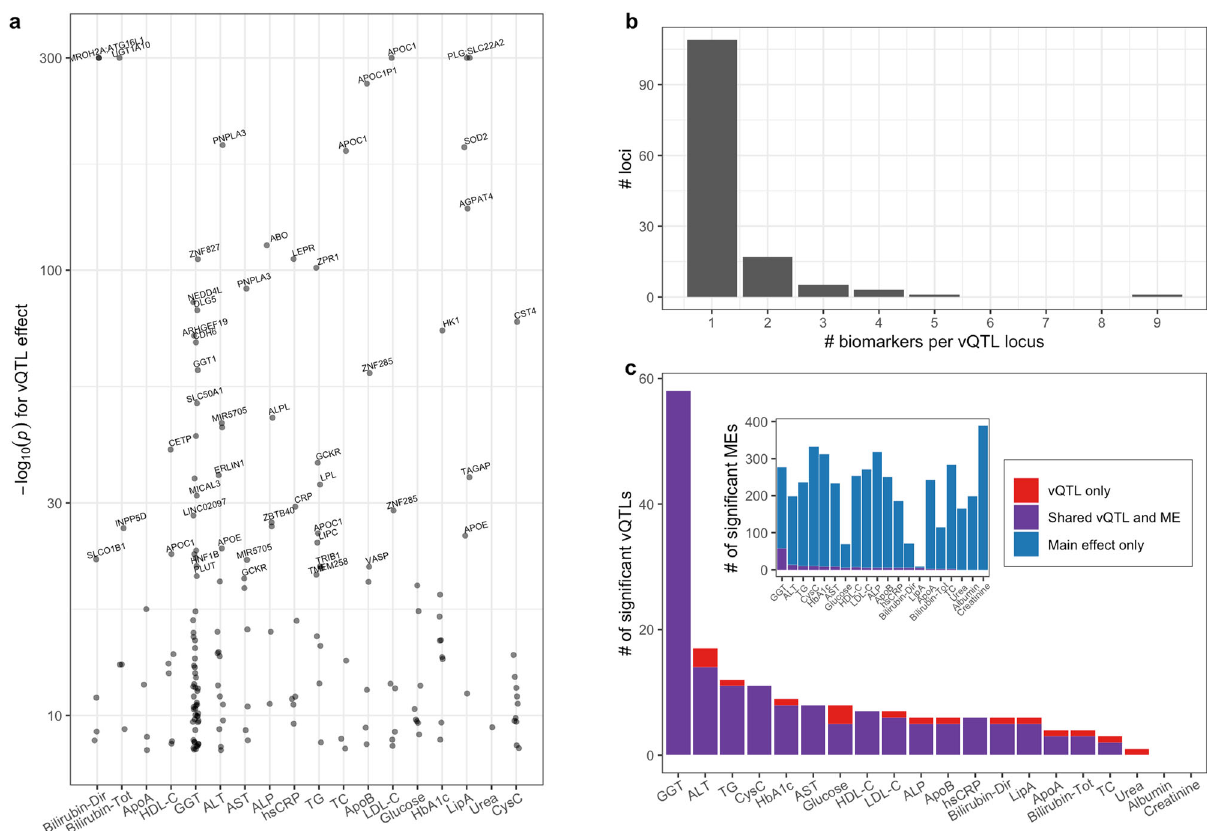
Fig. 2 vQTLs identi fi ed across 20 cardiometabolic serum biomarkers. a − log 10 P vQTL from Levene ’ s test is shown for all signi fi cant index variants for each biomarker. Labels correspond to the closest gene (shown for variants with P vQTL < 10 − 20 ), highlighting some known GWAS loci. P values are truncated at 10 − 300 for visualization purposes. b Histogram displaying the number of biomarker associations for each vQTL locus. c The number of signi fi cant vQTL loci is shown for each biomarker (inset: analogous plot for main effects). Colors denote three categories: vQTL loci not shared with an ME locus (red), vQTL loci shared with an ME locus (purple), and ME loci not shared with a vQTL locus